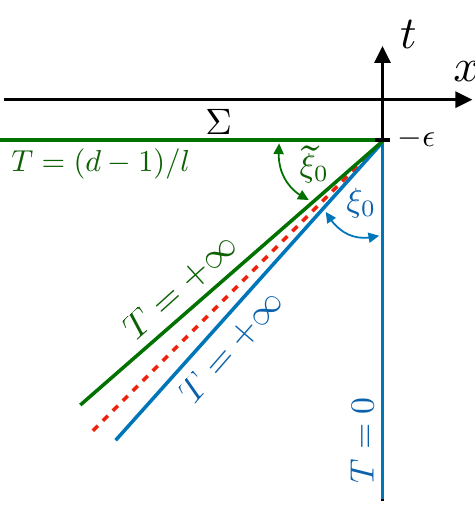
Figure 6 . Solutions in Lorentzian dS d +1 . Timelike half-planes (6.63), shown in blue, interpolate between the timelike plane x = 0 at T = 0 and null plane, dashed red, in the limit of T → + ∞ . Their inner angle ξ 0 given by (6.65) is shown in blue. Spacelike half planes (6.79), shown in green, interpolate between the spacelike boundary Σ at T = ( d − 1) /l and the null sheet for T → + ∞ . Their inner angle ˜ ξ 0 , given by (6.81), is shown in